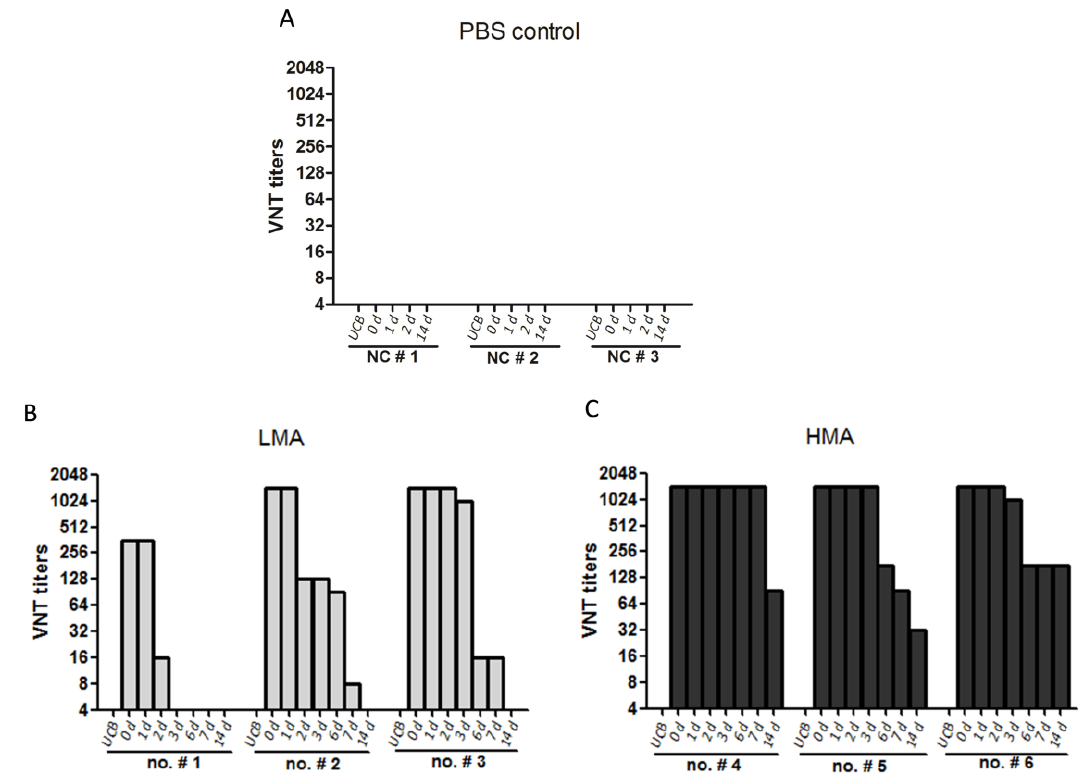
Figure 3. Dynamics of the MDAs in the colostrum/milk of sows immunized with SVA vaccines. The umbilical cord blood (UCB), the colostrum (day 0), as well as the milk secreted on day 1, 2, 3, 6, 7, and 14 after farrowing were collected from all the sows, and the SVA-specific neutralizing antibody titers at the indicated days were evaluated by VNT analysis, respectively. PBS group ( A ), LMA group ( B ), and HMA group ( C ).